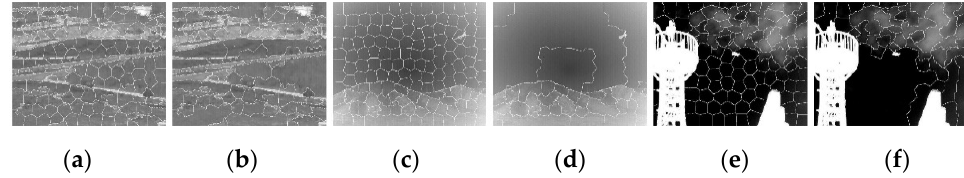
Figure 14. Refined results after merging similar initial superpixels. The initial superpixel maps of Figure 11f and the corresponding merged results are interlaced in ( a – f ).